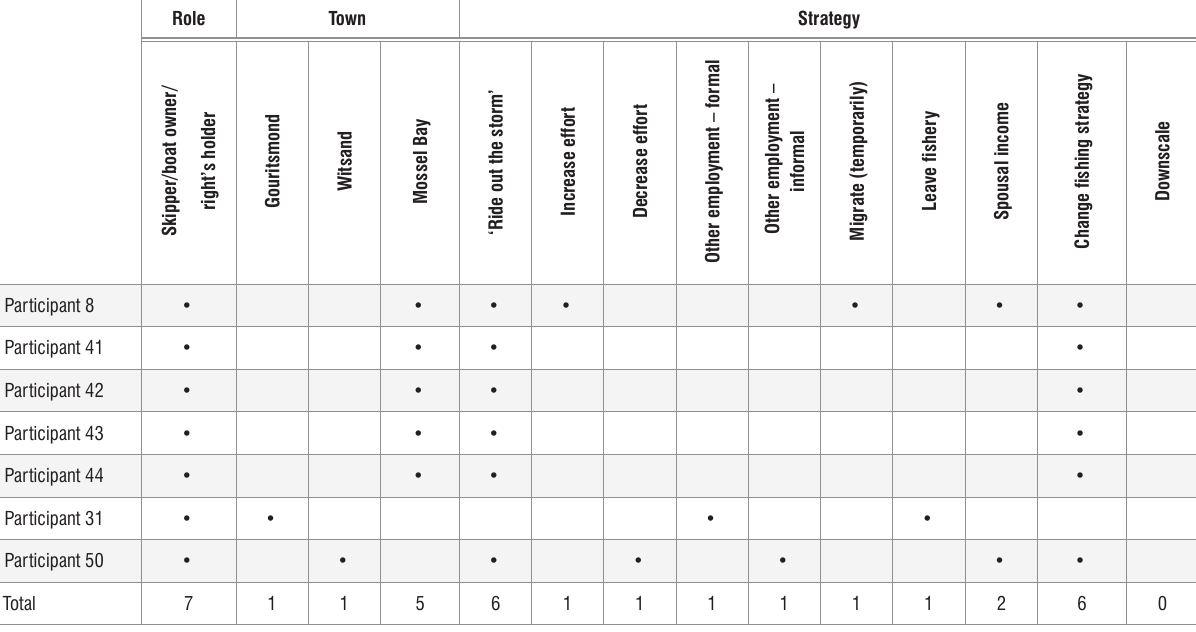
Table 3: Change responses implemented by the fishers from Mossel Bay, Gouritsmond and Witsand: business-oriented fishers Role Town